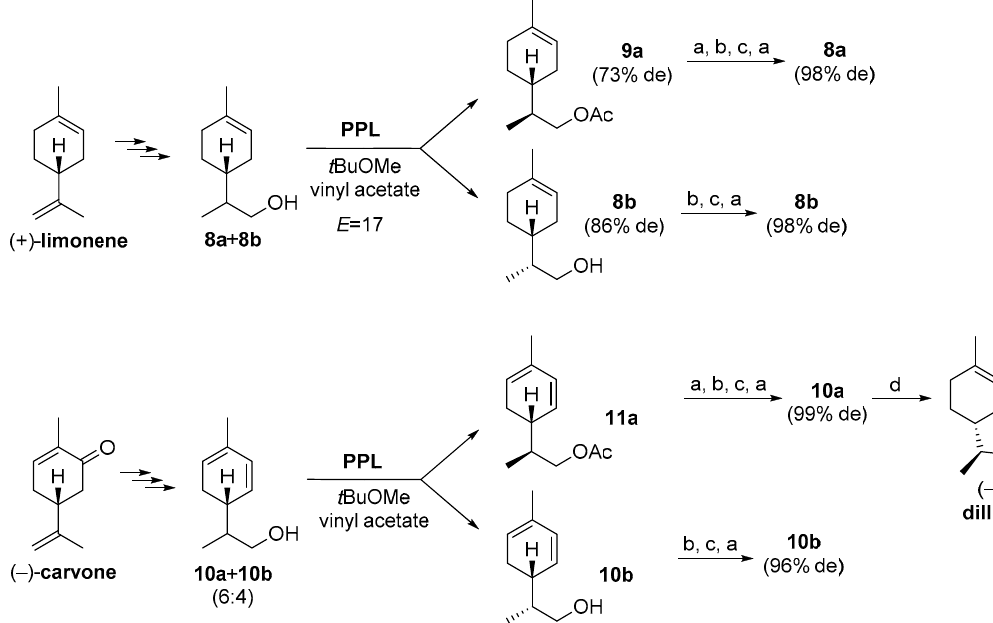
Figure 3. The PPL-mediated resolution of a mixture of two enantiopure diastereoisomeric alcohols. An application to the preparation of the chiral building blocks p -menth-1-en-9-ol ( 8 ) and p -menth-1,5-dien-9-ol ( 10 ). Reagents and conditions: ( a ) NaOH/MeOH; ( b ) 3,5-dinitrobenzoyl chloride/Py; ( c ) crystallization from hexane; and ( d ) BF 3 ·Et 2 O.